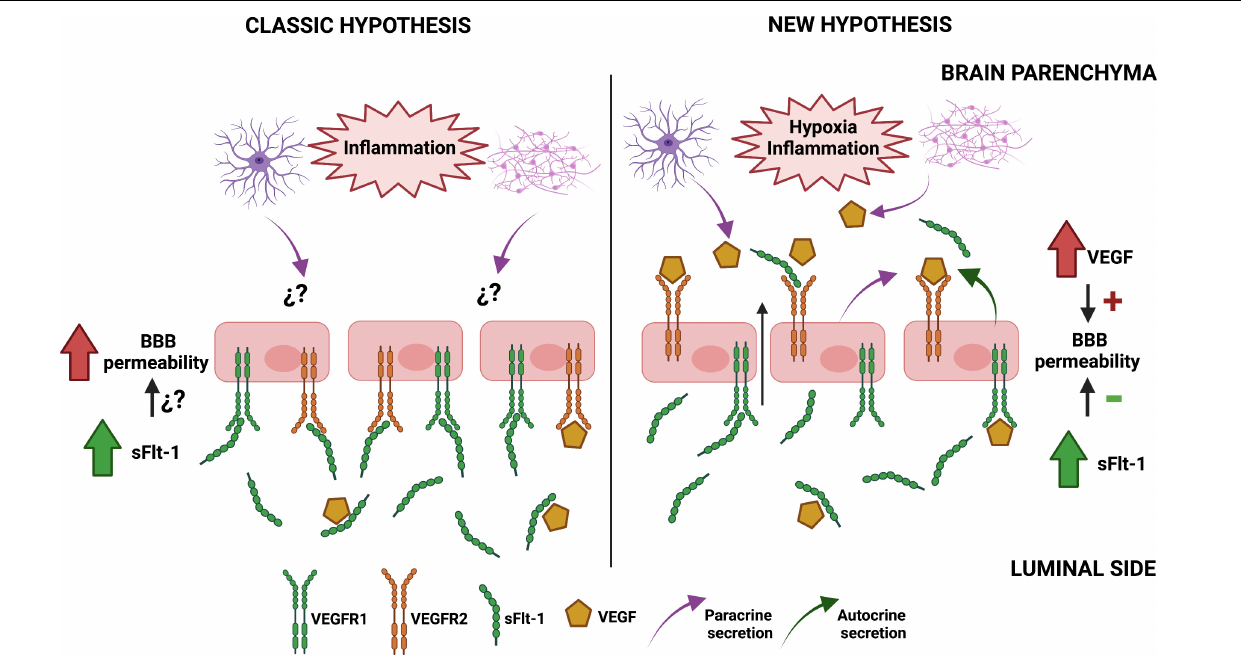
FIGURE 2 | Proposed mechanism of soluble tyrosine kinase-1 similar to fms (sFlt-1) effects on blood-brain barrier (BBB) integrity in preeclampsia. The classic model of endothelial dysfunction in preeclampsia (left) assumes that the alterations on BBB functionality mainly depend on high circulating levels of anti-angiogenic factors such as sFlt-1, as the expression of VEGFRs is similar to the observed in peripheral endothelial cells. However, our hypothesis (right) proposes that the basolateral expression of VEGFR2 in brain endothelial cells makes them more reactive to the paracrine secretion of VEGF from astrocytes and neurons under pro-inflammatory conditions, increasing BBB permeability. Therefore, the high circulating levels of sFlt-1 in the blood of preeclamptic women and the autocrine secretion of this protein in brain endothelial cells might exert a protective effect. The figure omitted the inclusion of other relevant factors in order to better compare both hypotheses. Created with